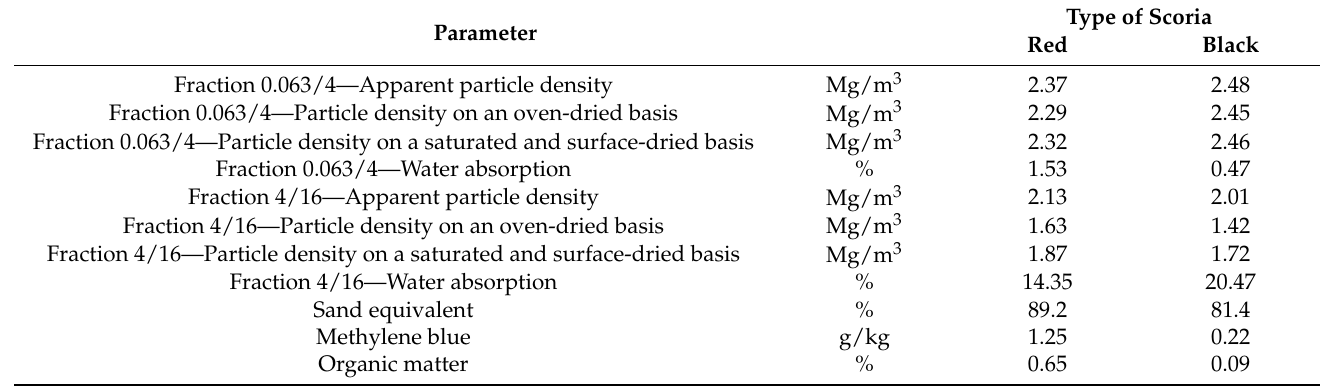
Table 2. Properties of the red and black